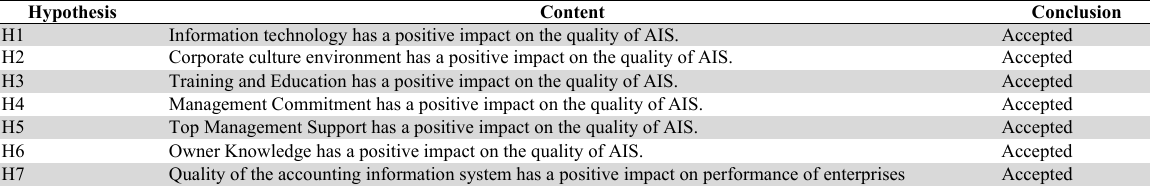
Test Results of research hypotheses